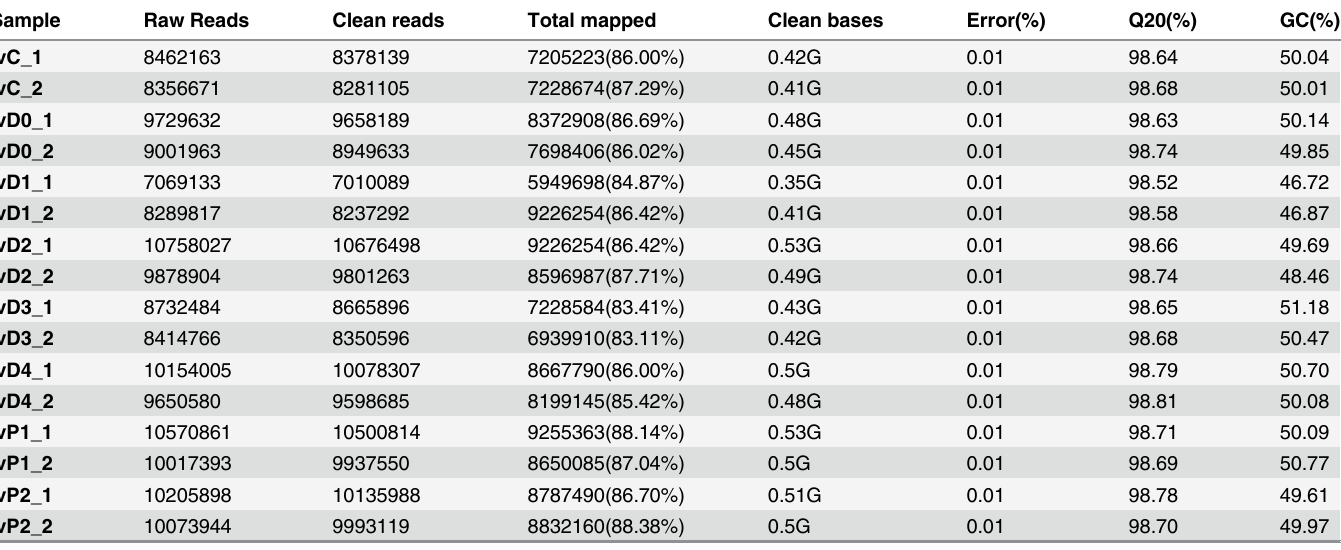
Table 1. An overview of sequencing and assembly of the shrimp transcriptome from L . vannamei .